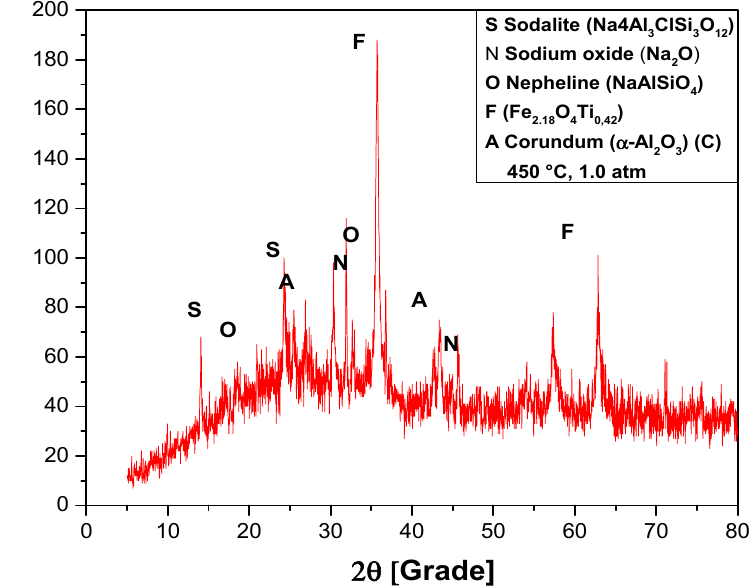
Figure 10. XRD of red mud pellets activated with 1.0 M HCl after the upgrading process.